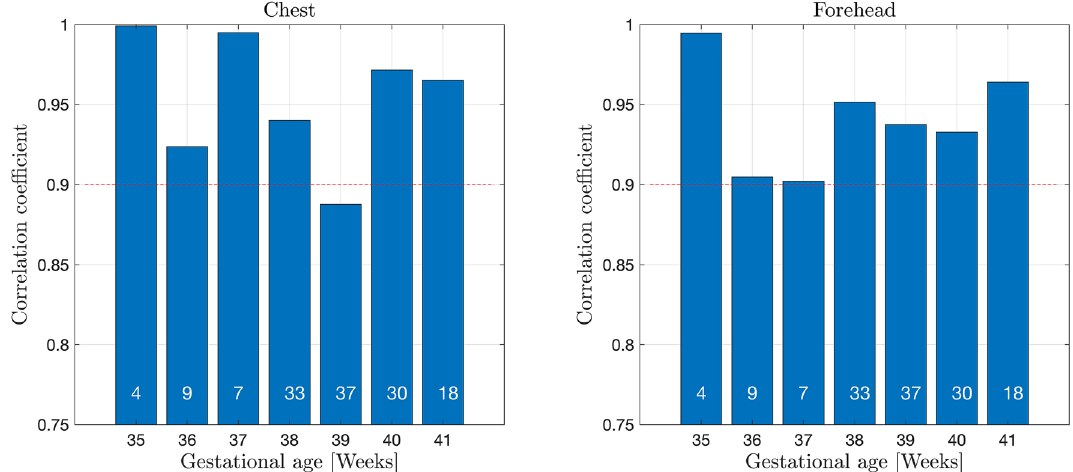
Figure 4. Correlation coefficients for t.c. bilirubin values measured with JM105 and JAISY at the forehead and chest, by gestational age. Numbers in each bar indicate the number of